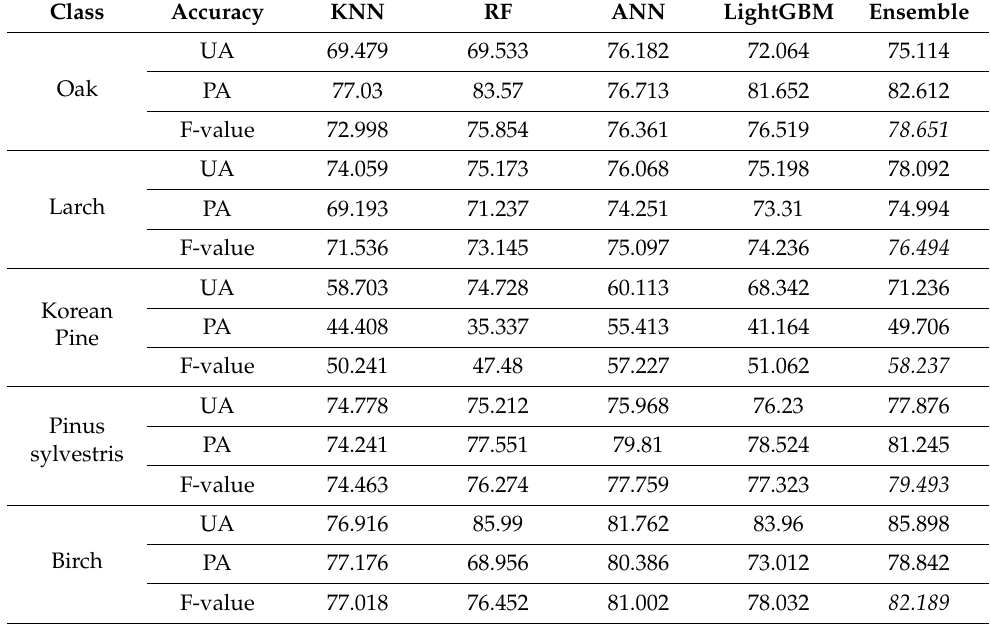
Table 9. Producer precision, user precision, and F-value (%) for each category for different methods in the other nine experiments (italics indicate the best